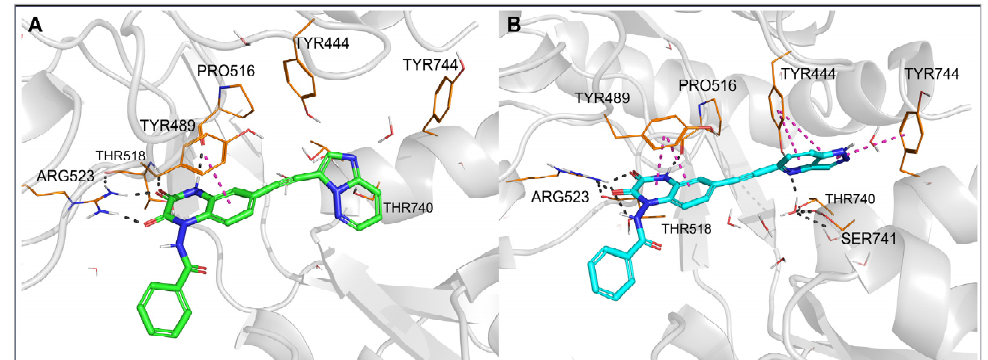
Figure 5. Complexes of the GluK1-LBD with compound 28 ( A ) and 29 ( B ), after 20 ns molecular dynamics simulation. Hydrogen bonds are marked with dark dashes, aromatic interactions are marked with pink dashes.